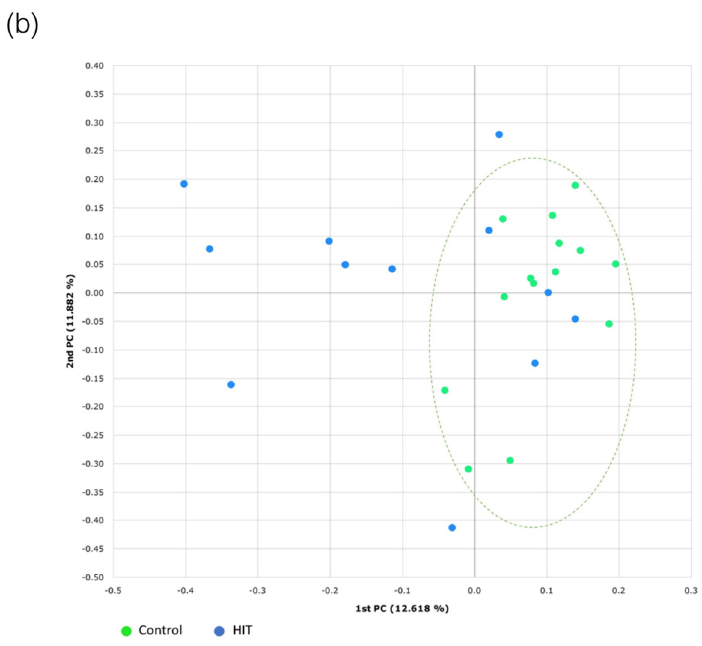
Figure 6. Beta diversity at the ( a ) genus and ( b ) species level determined by the Bray–Curtis index and principal coordinates analysis (PCoA). PC in both axes means “principal component”.